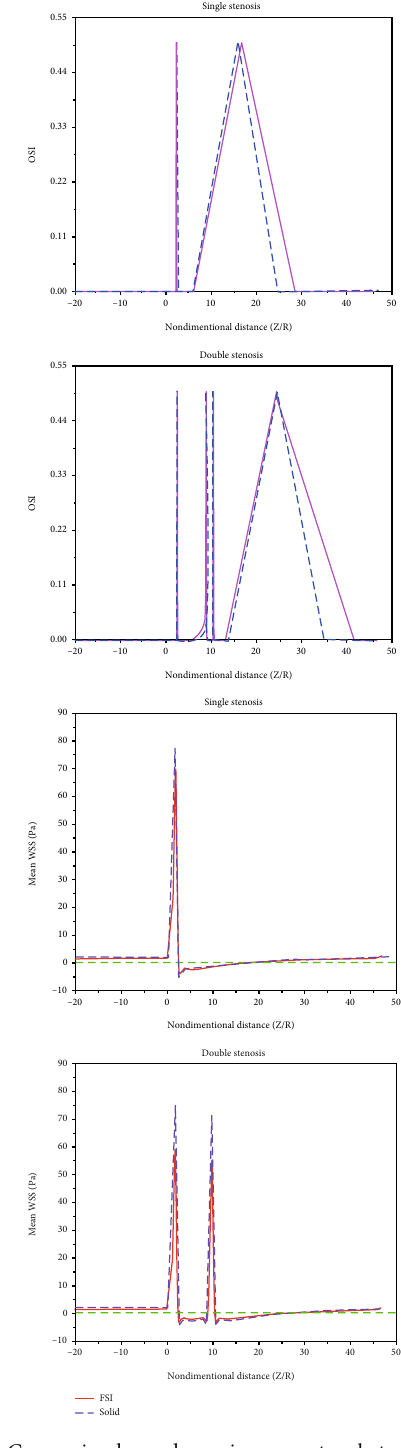
Figure 8: Comparing the velocity pro fi le between the rigid and elastic walls for double